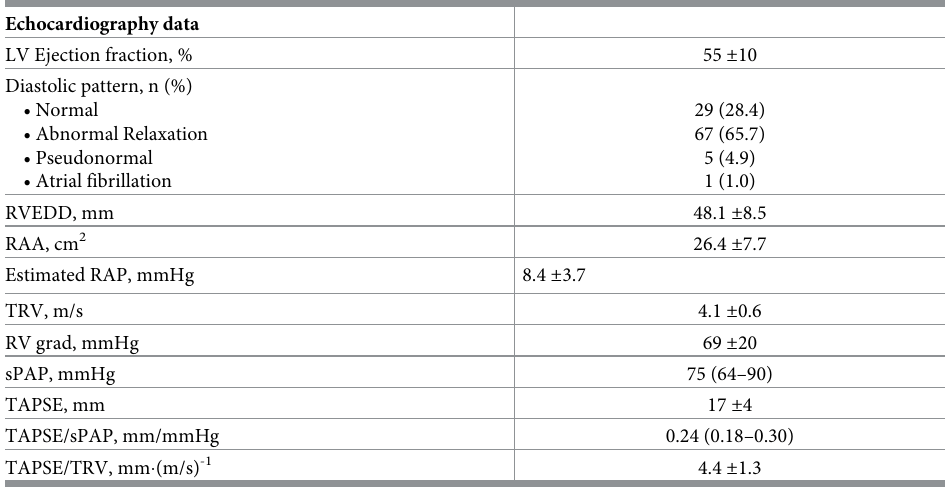
Table 2. Echocardiographic data (n